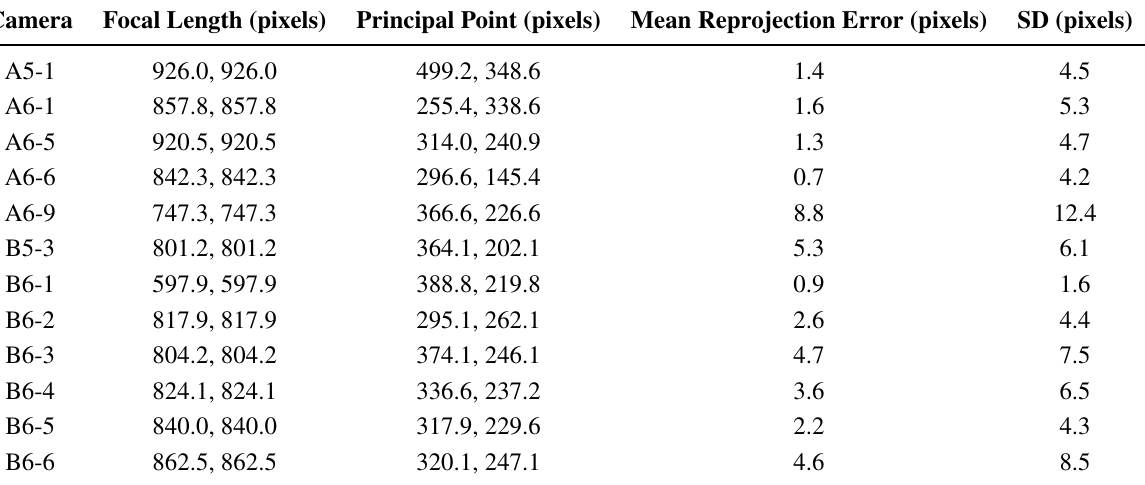
Table 1. Estimated internal camera parameters of the BRL